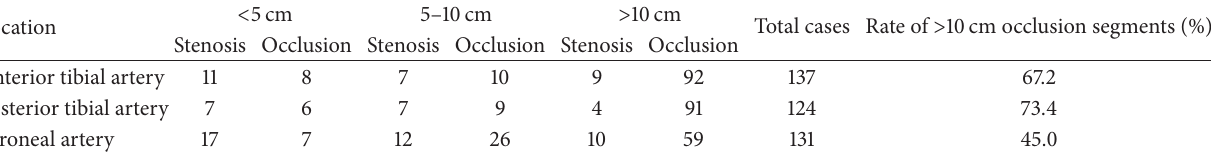
Table 4: The involvement extent of crural artery